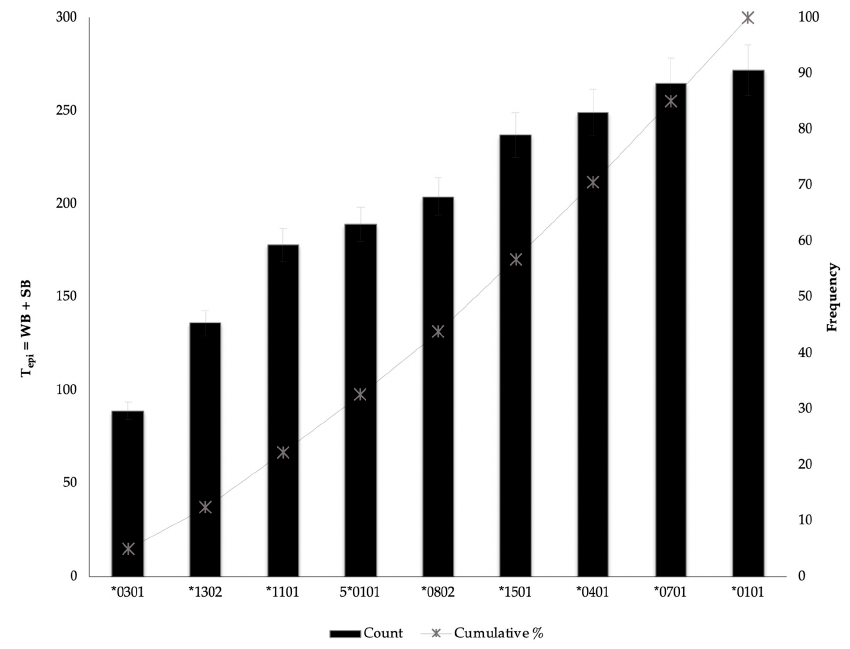
Figure 4. Pareto Analysis applied to rank the T epi of alleles against their percentage